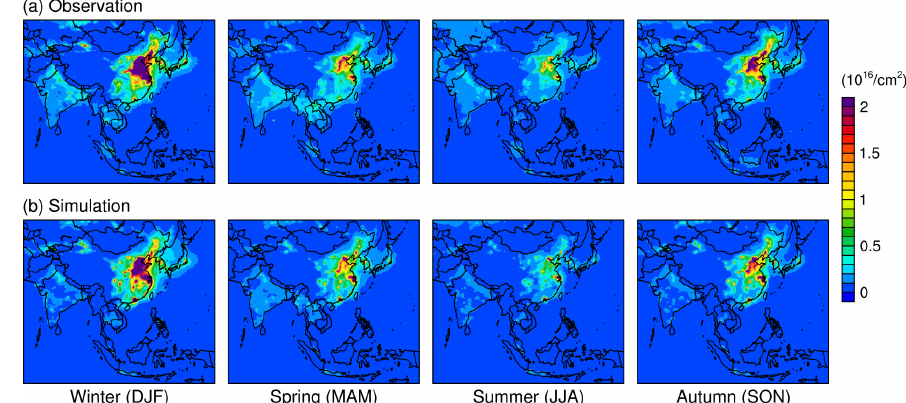
Figure 6. Horizontal distributions of observed and simulated seasonal mean tropospheric column NO 2 in BASE for